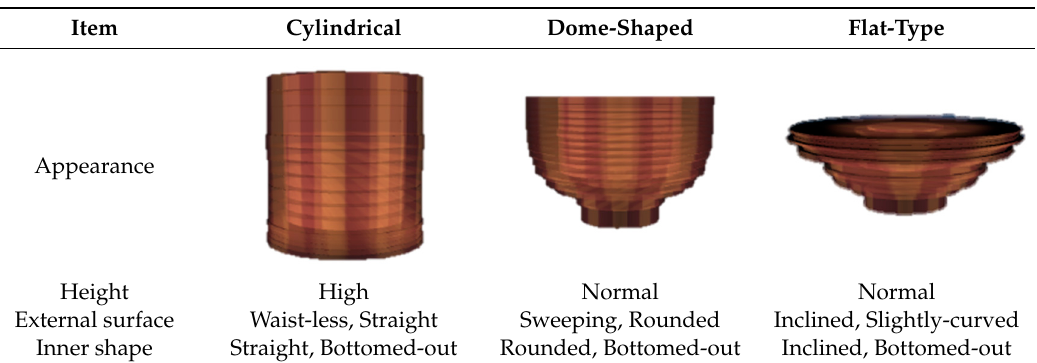
Table 5. Sample of bowl shapes.